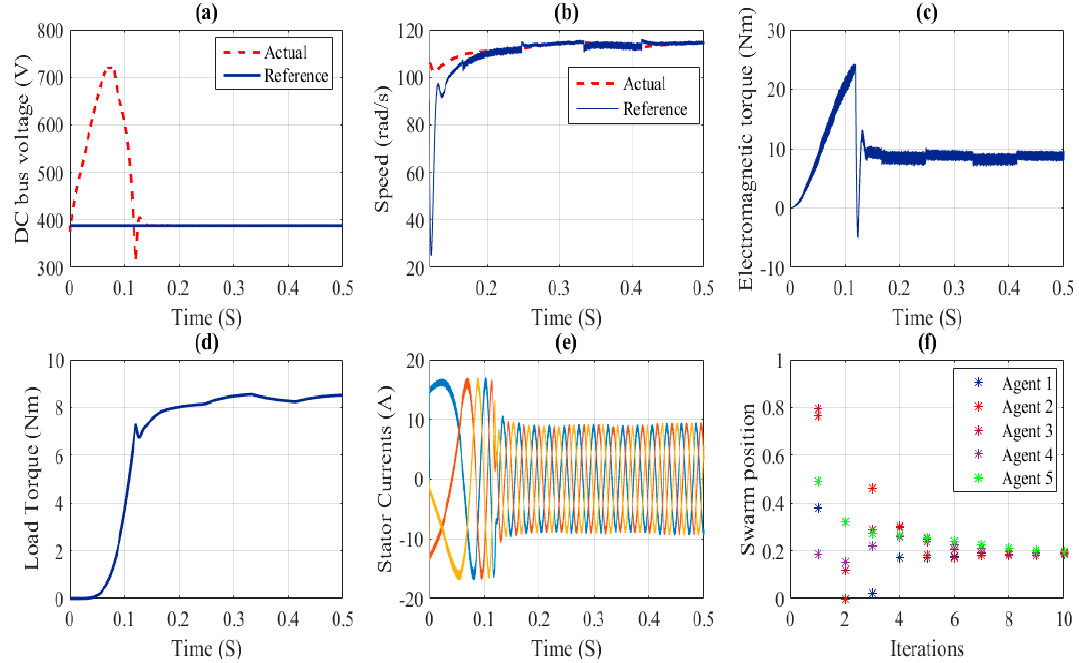
Figure 11. The detailed performance of SPVWP system under second scenario using SSA based tracker. ( a ) DC bus voltage; ( b ) motor speed; ( c ) electromagnetic torque; ( d ) load torque; ( e ) stator currents; ( f ) swarm position vs. number of iterations.